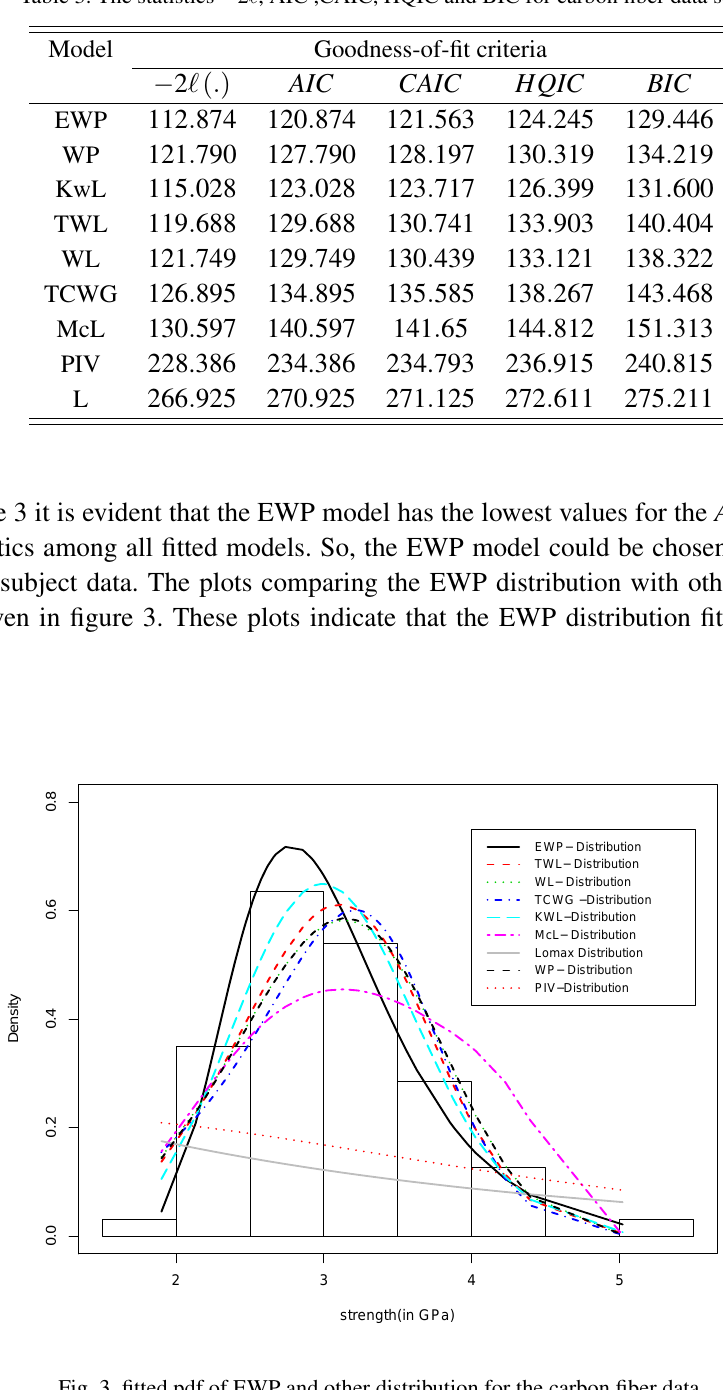
Fig. 3. fitted pdf of EWP and other distribution for the carbon fiber